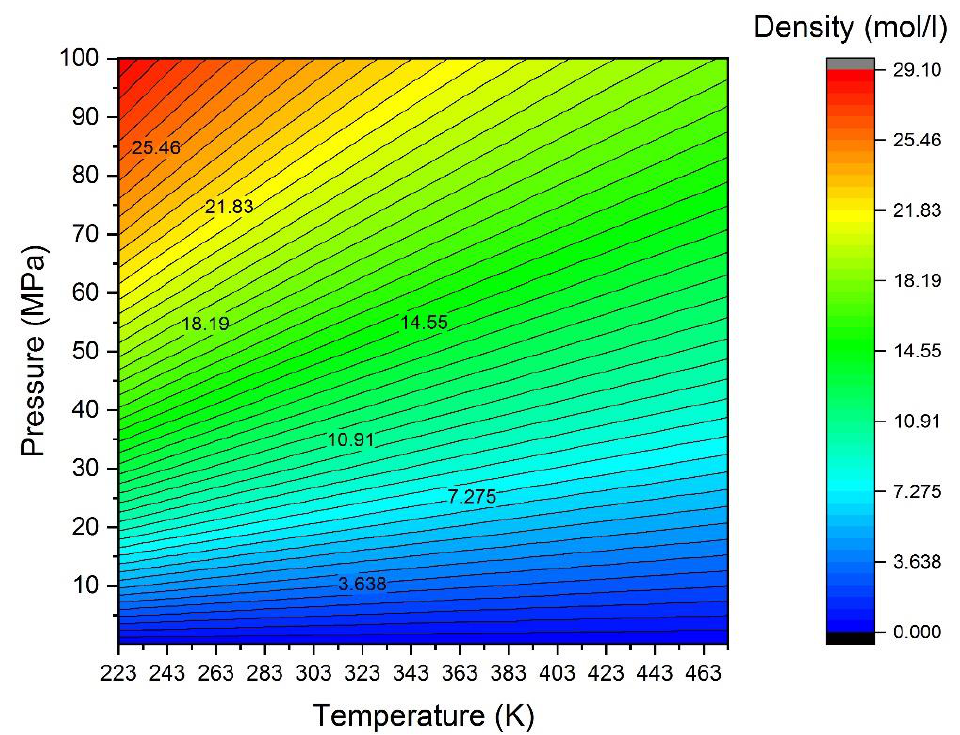
Figure 6. Hydrogen density levels as a function of pressure and temperature. Data processed from [40].